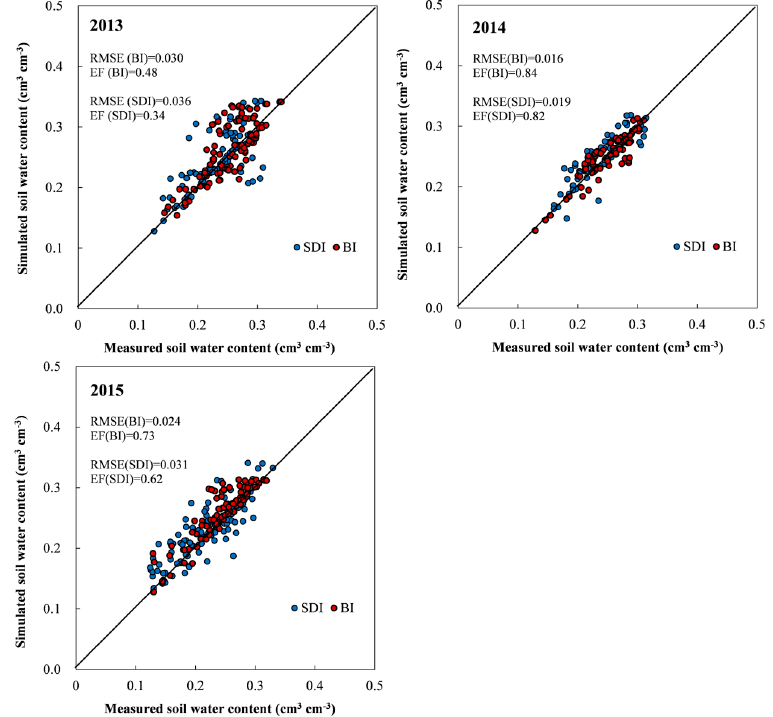
Figure 10. Comparison of the simulated and observed soil water contents (SWCs) under the two irrigation methods. irrigation